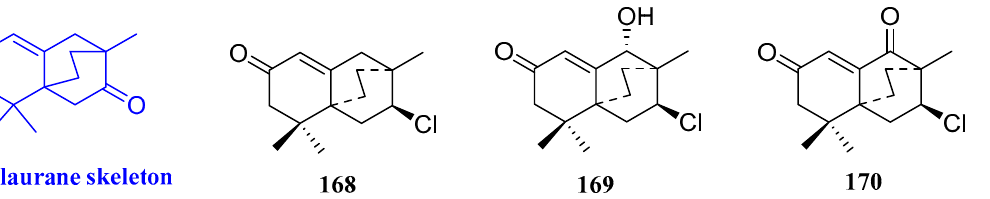
Figure 21. Structures of rhodolaurane - type sesquiterpenoids 168 – 170 .